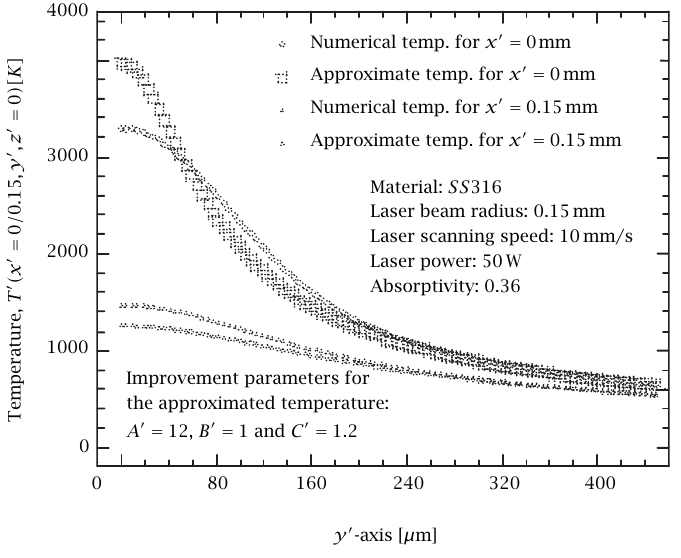
Figure 2.8 . Comparison between the numerical and approximate tempera- tures in the y (cid:1) -direction for different values of x (cid:1)